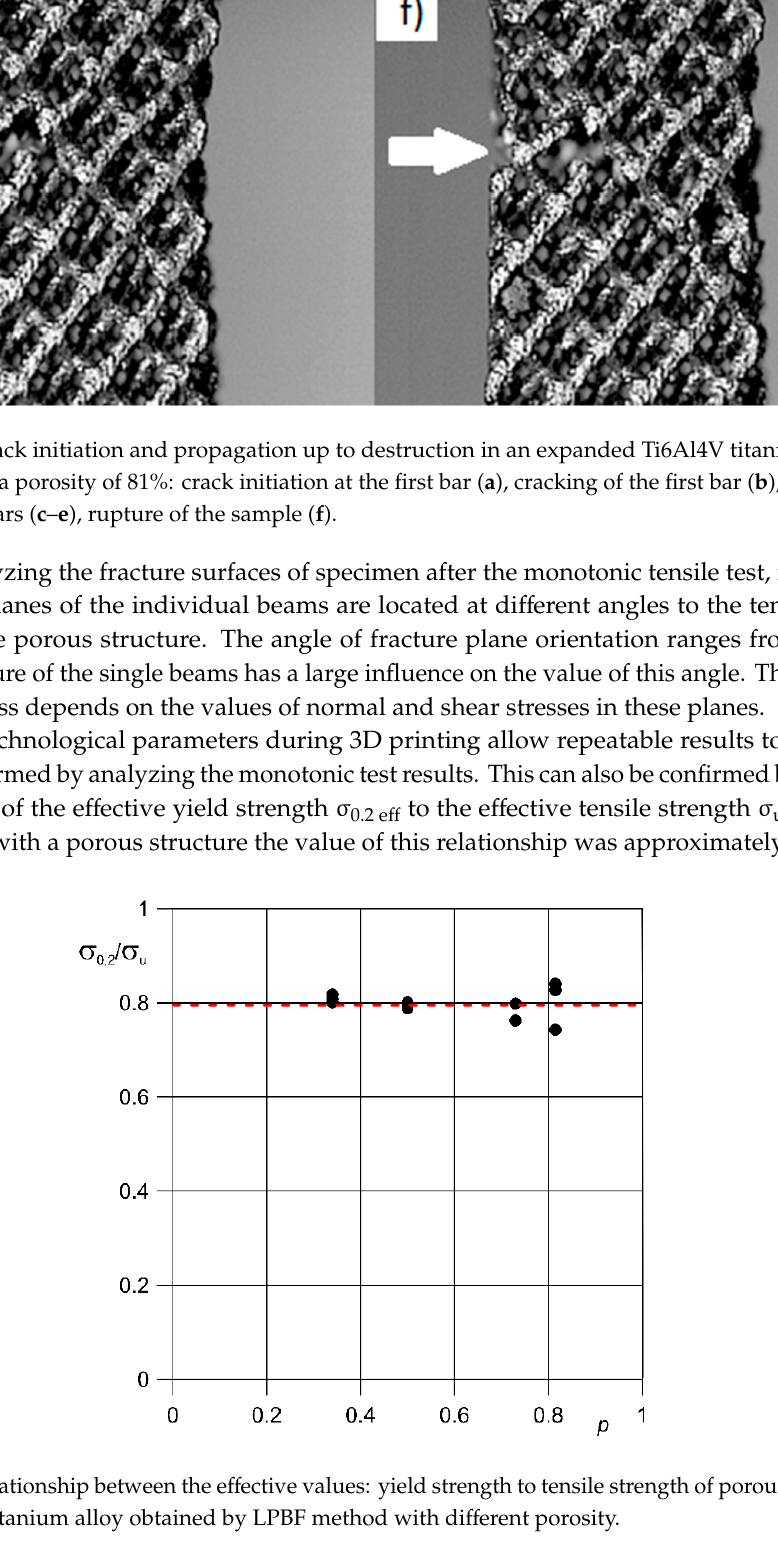
Figure 7. Relationship between the e ff ective values: yield strength to tensile strength of porous samples of Ti6Al4V titanium alloy obtained by LPBF method with di ff erent